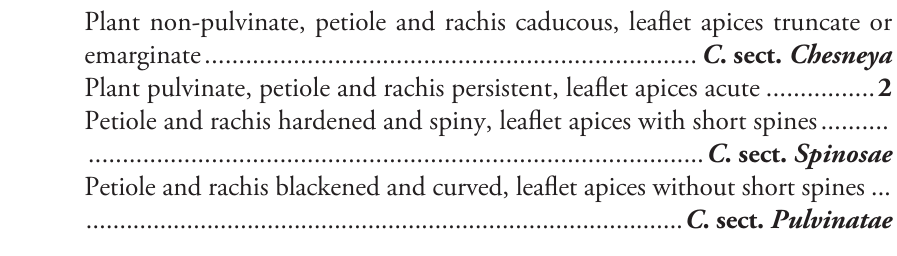
Fig. 3D Spongiocarpella Yakovlev & N. Ulziykhutag, Bot. Zhur. 17(2): 249. 1987. Type: Spongiocarpella nubigena (D.Don) Yakovl., Bot. Zhur. 17(2): 249. 1987. Type. Chesneya nubigena (D.Don) Ali, Scientist (Karachi) iii: 4. 1959. Description, distribution and habitat. This psychric section is composed of C. nubigena , C. polystichoides (Hand.-Mazz.) Ali and C. purpurea . It differs from other sections by blackened, curved and non-spiny petiole and rachis, distributed on high- altitude slope in eastern Himalayas and southern and eastern Tibet.